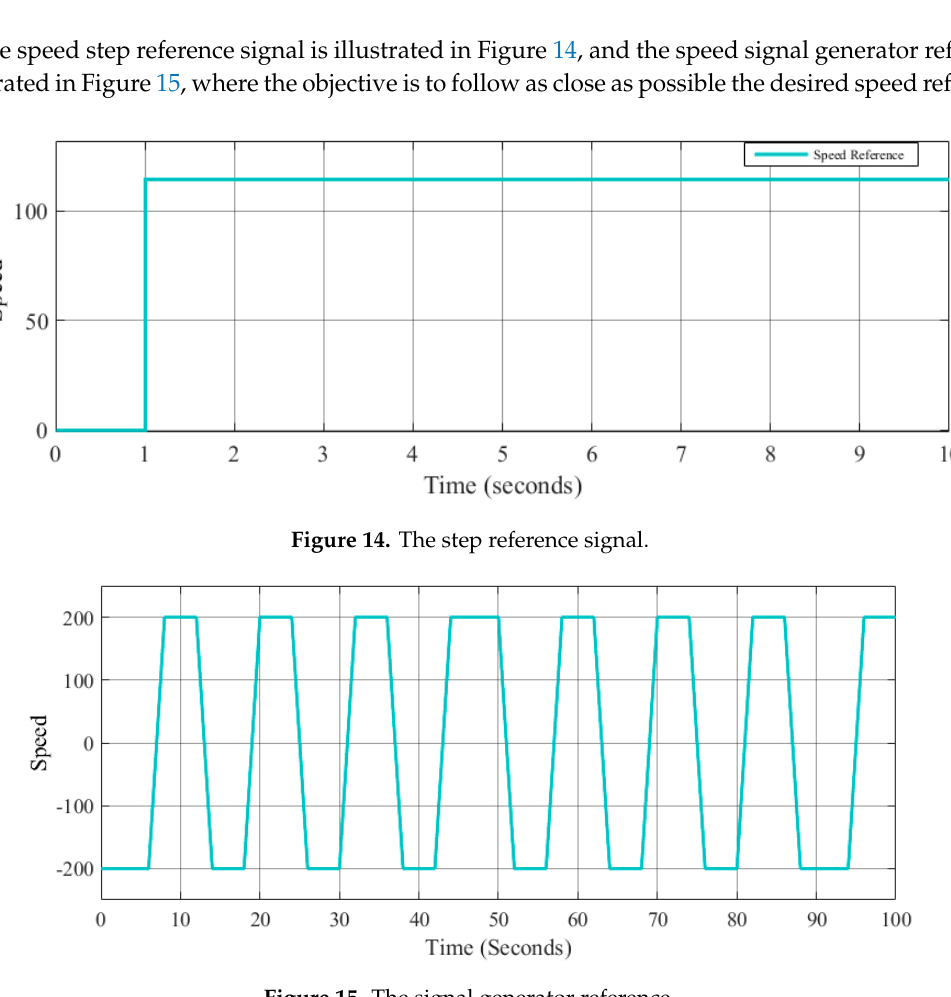
Figure 15. The signal generator